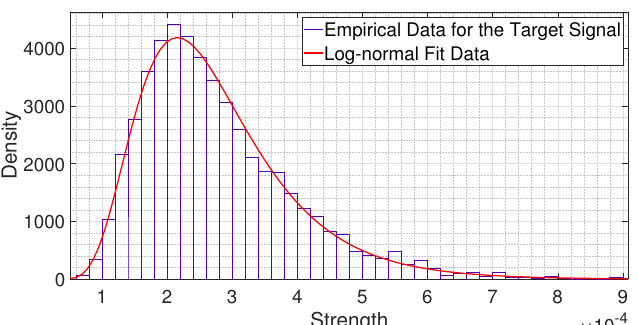
Figure 5. Comparison of the statistical data on the empirical strength with the fitting result for the signal reflected from a